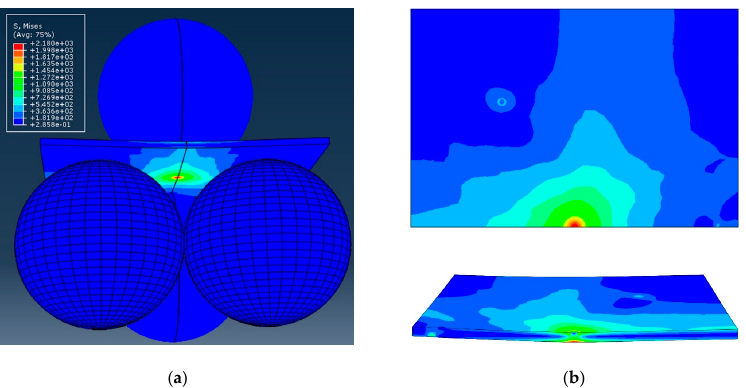
Figure 5. Example of the principal stress field in a rectangular plate specimen for a typical loading condition in a ball-on-3-balls test: ( a ) perspective view, and ( b ) view on the top plane and section view of the